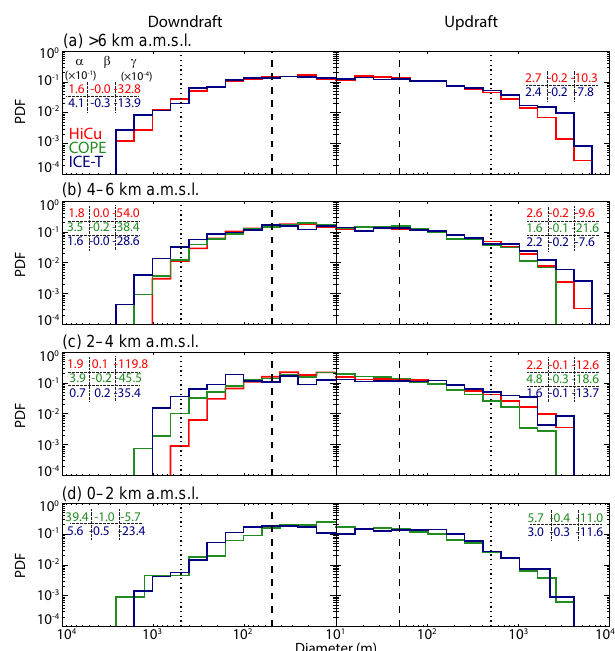
Figure 4. PDFs of the diameters for the updrafts and downdrafts sampled at 0–2, 2–4, 4–6, and higher than 6km. The numbers shown in each panel are the coefficients of the fitted exponential function (Eq.